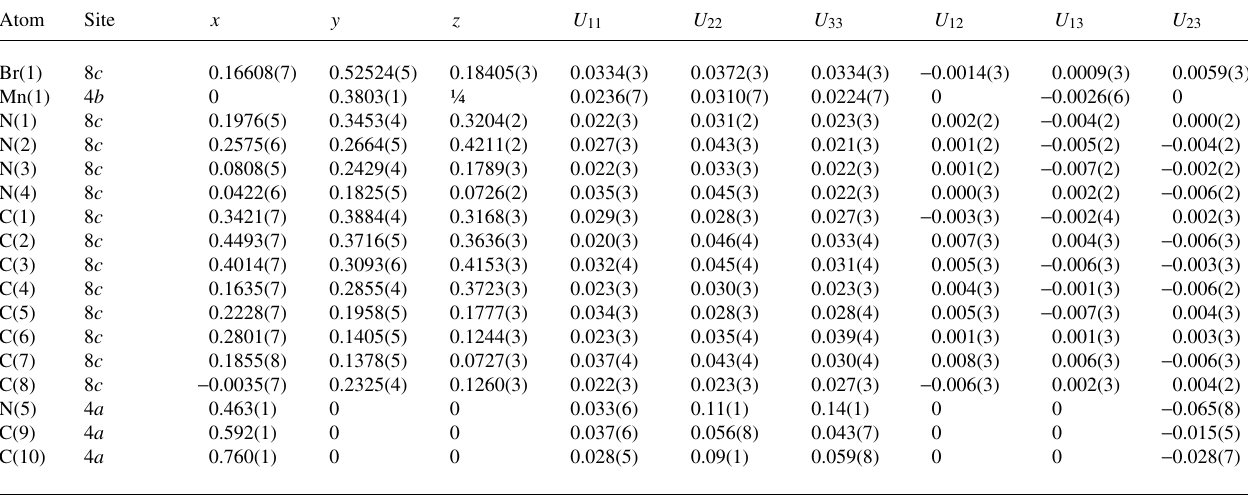
Table 3. Atomic coordinates and displacement parameters (in Å 2 ) .